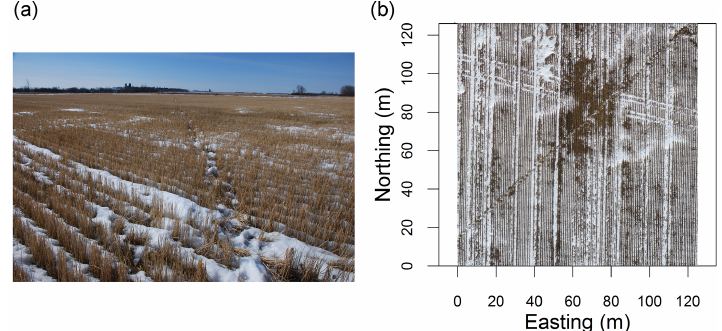
Figure 9. (a) An oblique photograph demonstrates the issue of tall stubble obscuring underlying snow cover when considered in contrast to (b) a UAV orthomosaic of the same area on the same date that clearly shows widespread snow cover.